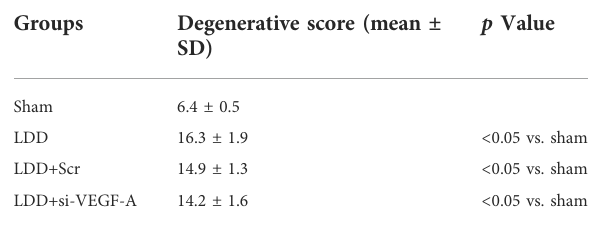
Groups:Group1,micereceivedshamoperationandinjectionofemptysolventofequal volume(Sham);Group2,micereceivedLDDinductionbysurgicalremovalofthespinal muscles, ligaments from supraspine and intraspine and posterolateral halves of the bilateral zygapophysial joints and injection of empty solvent of equal volume (LDD); Group3,micereceivedLDDinductionandsimultaneousorthotopicinjectionof100 µl 10 11 scramble-AAVs (LDD+Scr); Group 4, mice received LDD induction